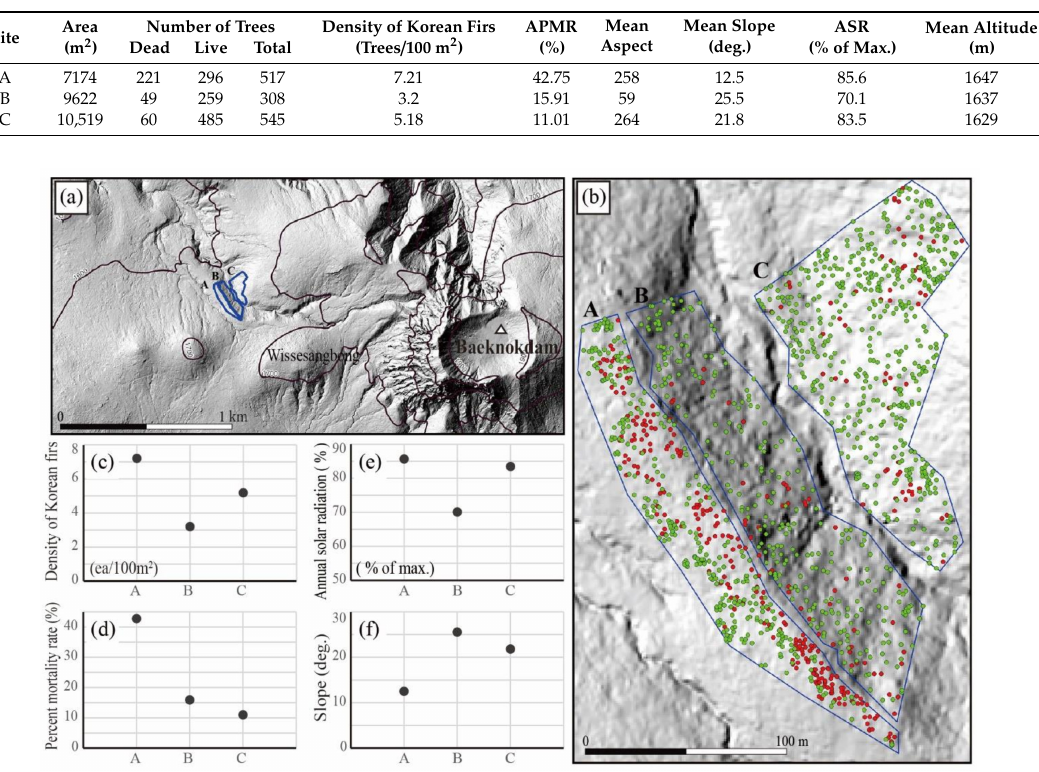
Figure 5. ( a – c ) and ( d – f ) show the altitudinal variation of APMR, density of Korean fir, and annual solar radiation in the three sections on the eastern and the western sections of Mt. Halla, respectively. Locations of each section are shown in Figure 2. Table 9. Distribution features of the Korean fir within three small sites with di ff erent topographic features.